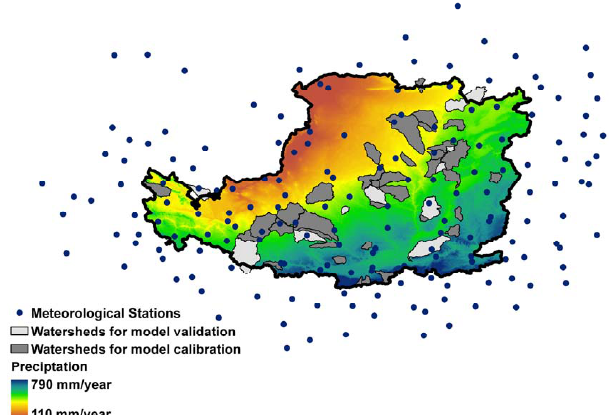
Fig. 2. Spatial distributions of gauged watersheds and meteorological stations used for model development and application